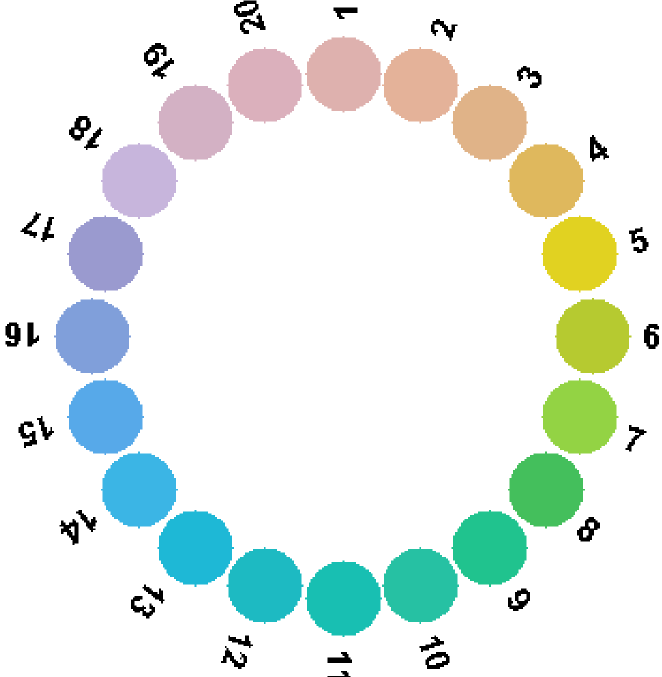
Fig 11. Pictorial representation of the 20 Munsell papers lying inside the metamer mismatch volume of flat grey for the green-to-neutral illumination condition. The colours in the figure only approximate those of the actual Munsell papers. For the correct colours refer to the actual Munsell papers, which starting from 1 are: 5R 8/6, 10R 8/6, 5YR 8/6, 10YR 8/8, 5Y 8.5/12, 10Y 8/10, 5GY 8/10, 10GY 7/10, 5G 7/10, 10G 7/ 8, 5BG 7/8, 10BG 7/8, 5B 7/8, 10B 7/8, 5PB 7/8, 10PB 7/8, 5P 7/8, 10P 8/6, 5RP 8/6, and 10RP 8/6.